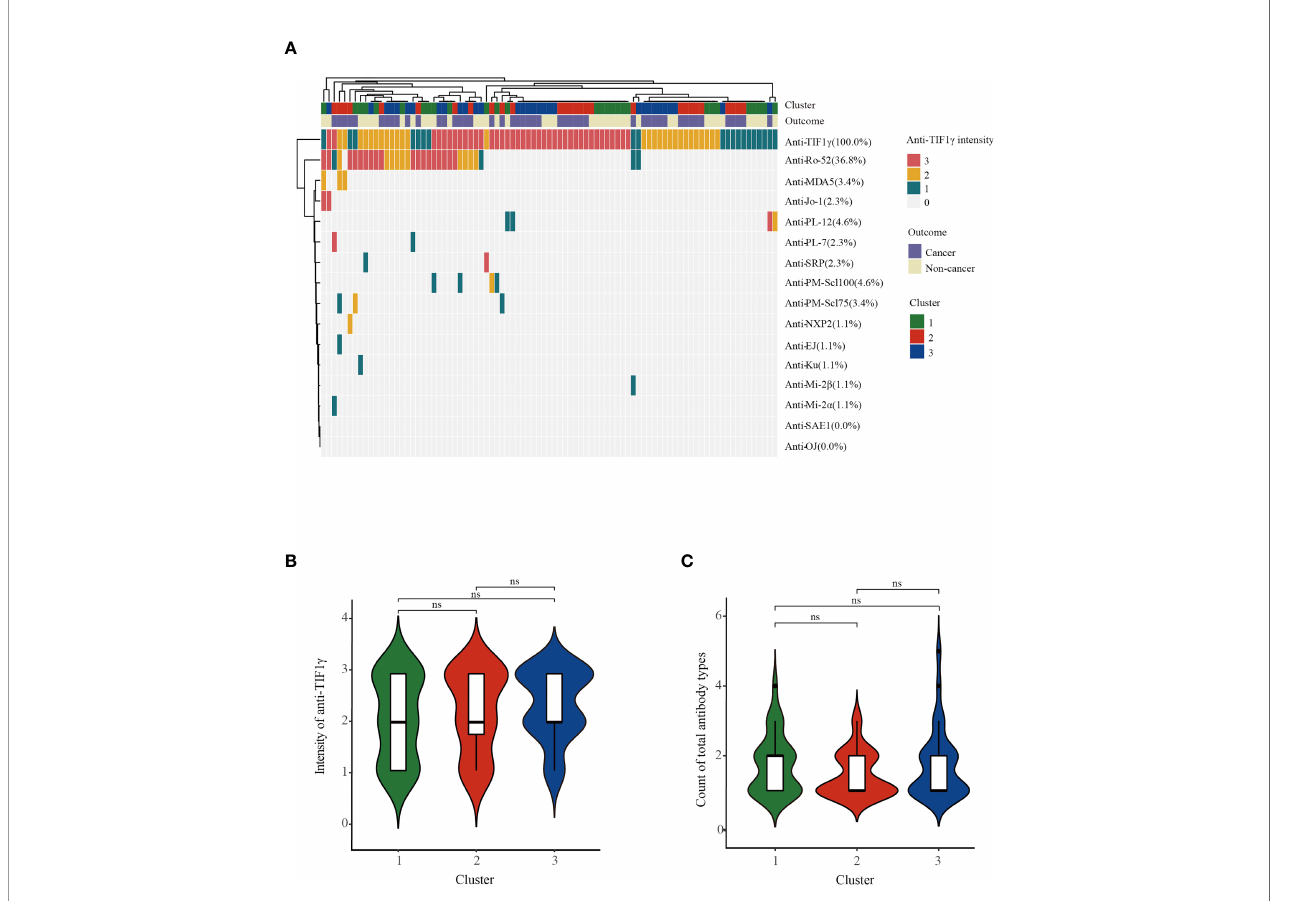
FIGURE 3 | (A) The heatmap showed the autoantibody pro fi le of 87 anti-TIF1 g + myositis patients. (B) The comparison of anti-TIF1 g intensities and (C) the comparison of count of total antibody types among anti-TIF1 g + myositis patients in three clusters. n.s. represents no signi fi